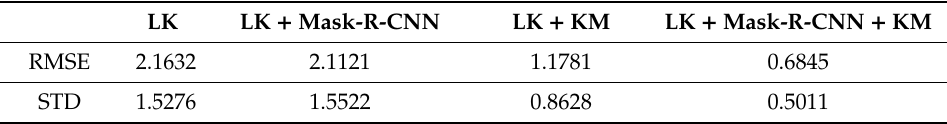
Table 3. Velocity errors of four algorithms in the X